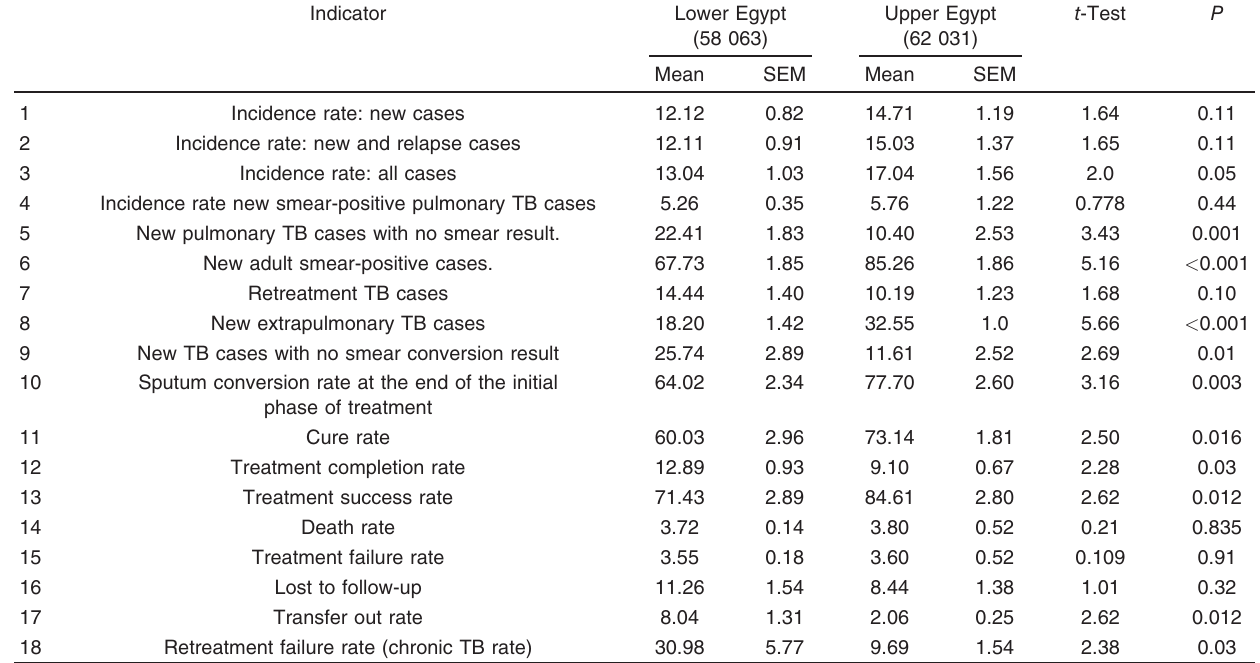
Table 7 Indicators of tuberculosis in Lower and Upper Egypt